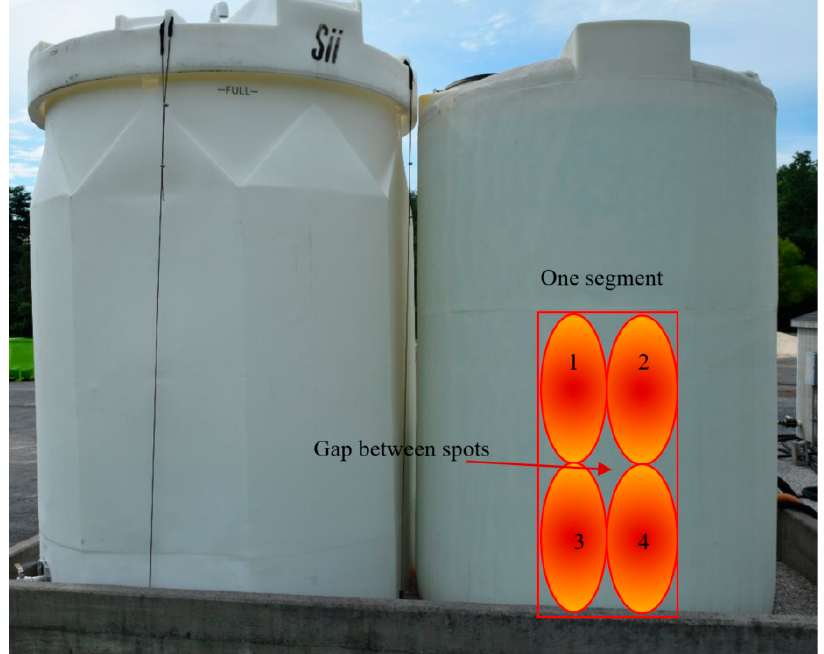
Figure 18. Image of two in-service HDPE ASTs with configuration of one segment consisting of four heated spots labeled.